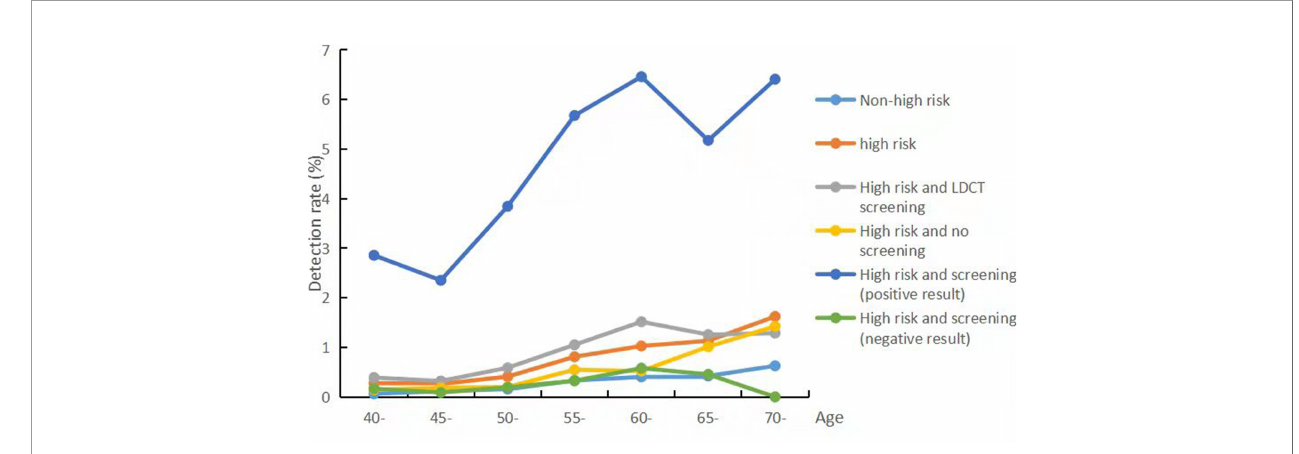
FIGURE 4 | Detection rates of lung cancer in different groups, 2013-2019.